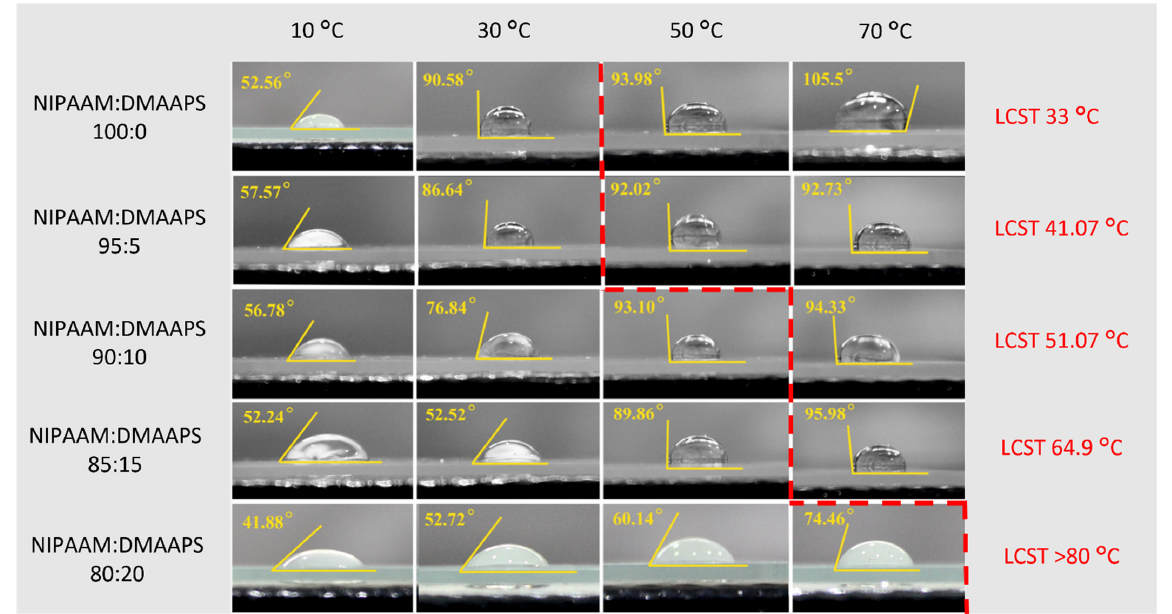
Figure 5. Contact angle analysis of co-polymers at different temperatures.